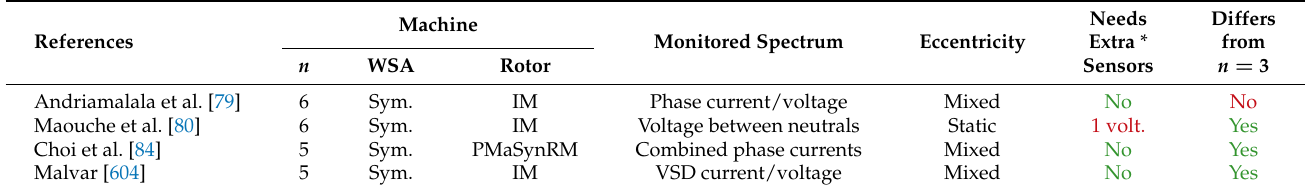
Table 27. Methods for detecting eccentricity faults (Section 12.6.1) in multiphase applications in the